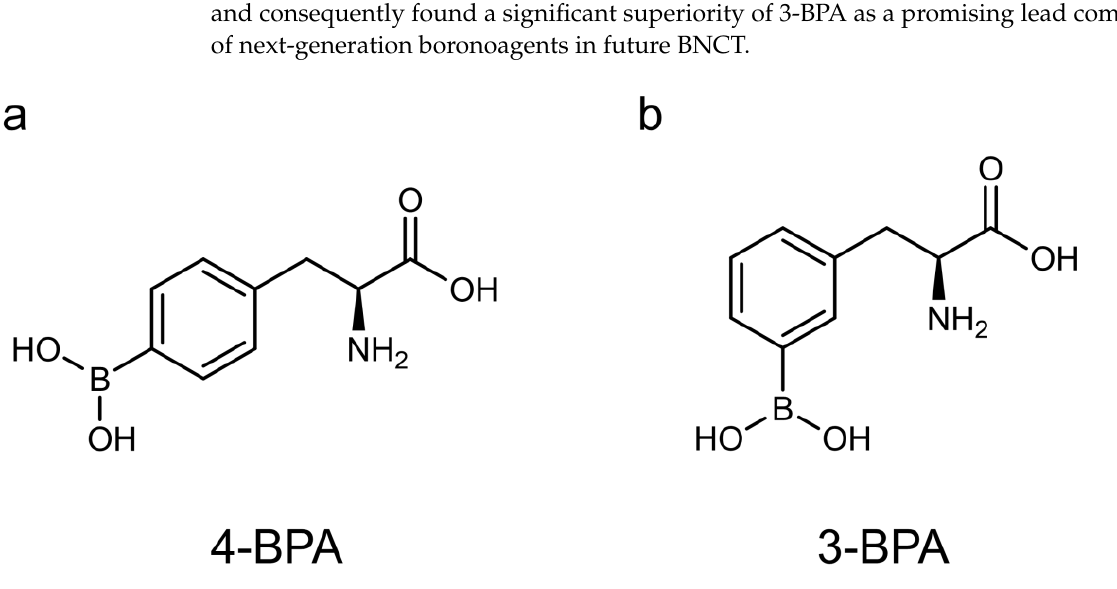
Figure 1. Chemical structure of 4-borono- L -phenylalanine (4-BPA, ( a )) and 3-borono- L -phenylalanine (3-BPA, ( b )).